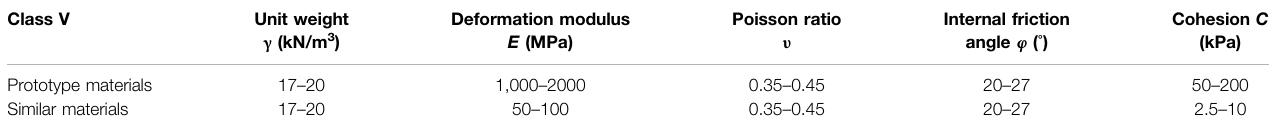
TABLE 5 | Physical and mechanical parameters of Class V surrounding rock prototype and similar